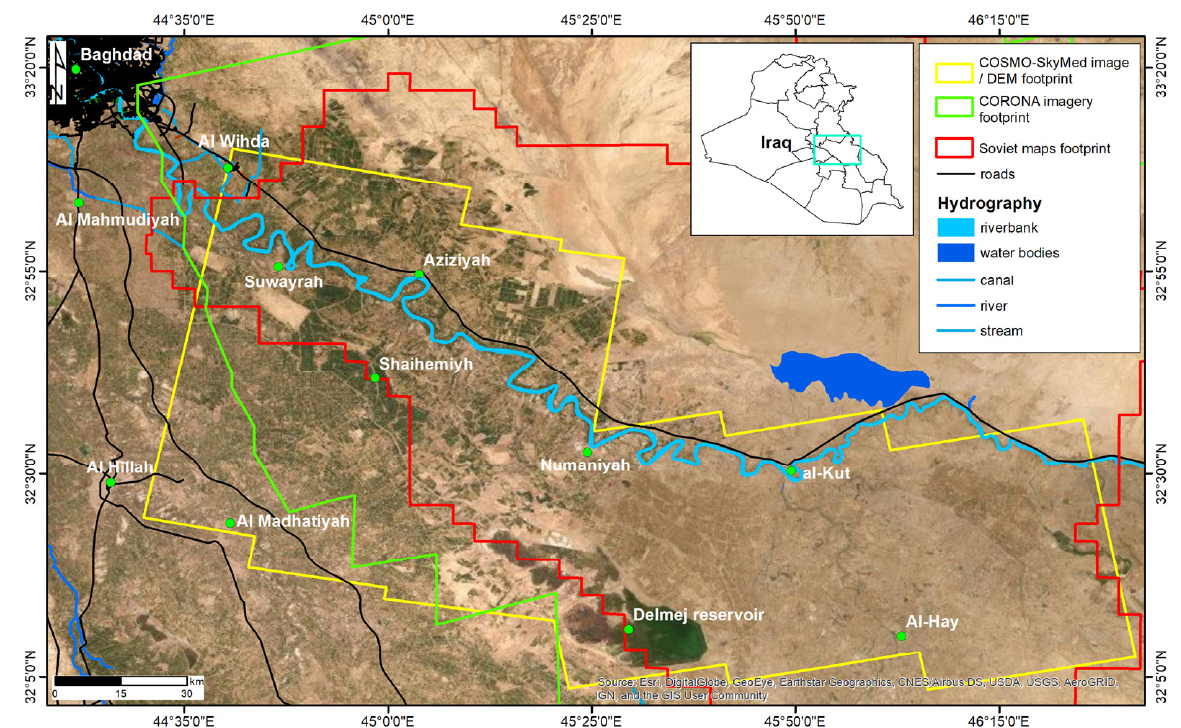
Figure 1. Location of Wasit study area in central Iraq and spatial extent of: the bespoke collection of COSMO-SkyMed StripMap (SM) HIMAGE acquisitions from which the digital elevation model (DEM) was generated; CORONA imagery; and Soviet maps (see Sections 2.2–2.4, respectively). Iraq roads and waterways from OpenStreetMap.org are displayed onto ArcGIS basemap image.